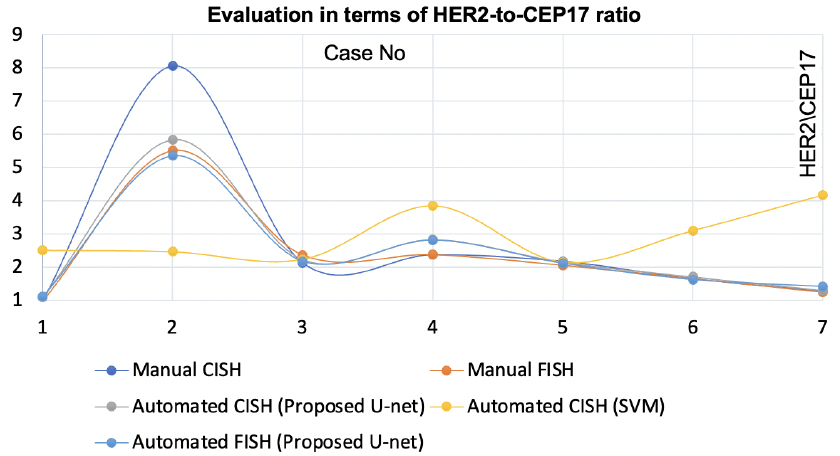
Figure 12. Evaluation of proposed nuclei segmentation enabled automatic HER2 quantification using both CISH and FISH with respect to the HER2 ––CEP17